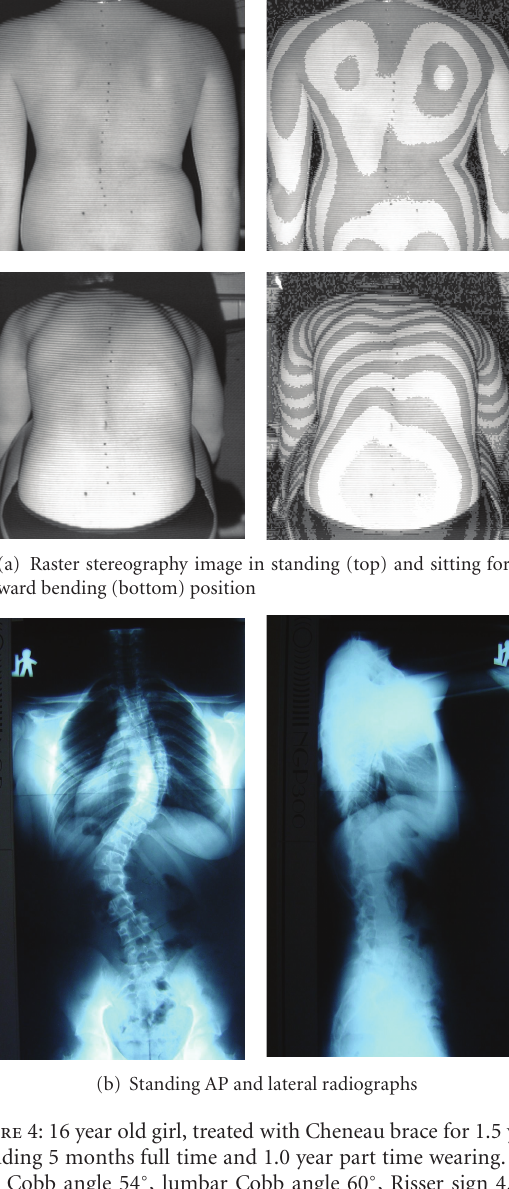
Table 1: Curve pattern in both groups.